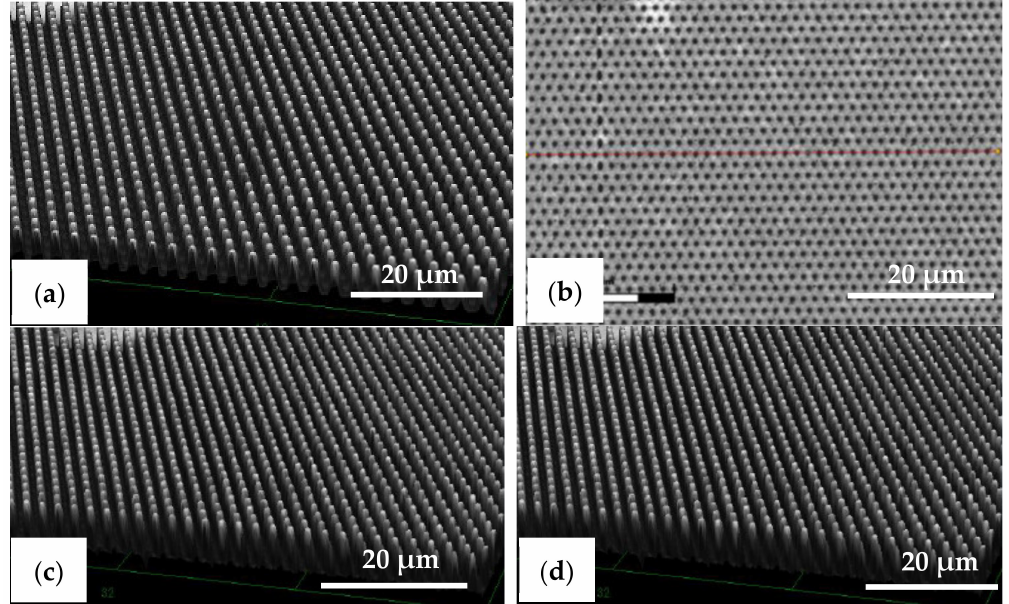
Figure 10. Laser confocal microscopy images of the pillar micro-structure (designed pattern size: diameter: 0.5 µ m, height: 2.5 µ m) on the ( a ) Si master mold before in-house releasing agent treatment, ( b ) R2P NIL flexible stamp (holes, top-view), ( c ) imprint on PC foil with resin A (PIL-A), and ( d ) imprint on PC foil with resin B